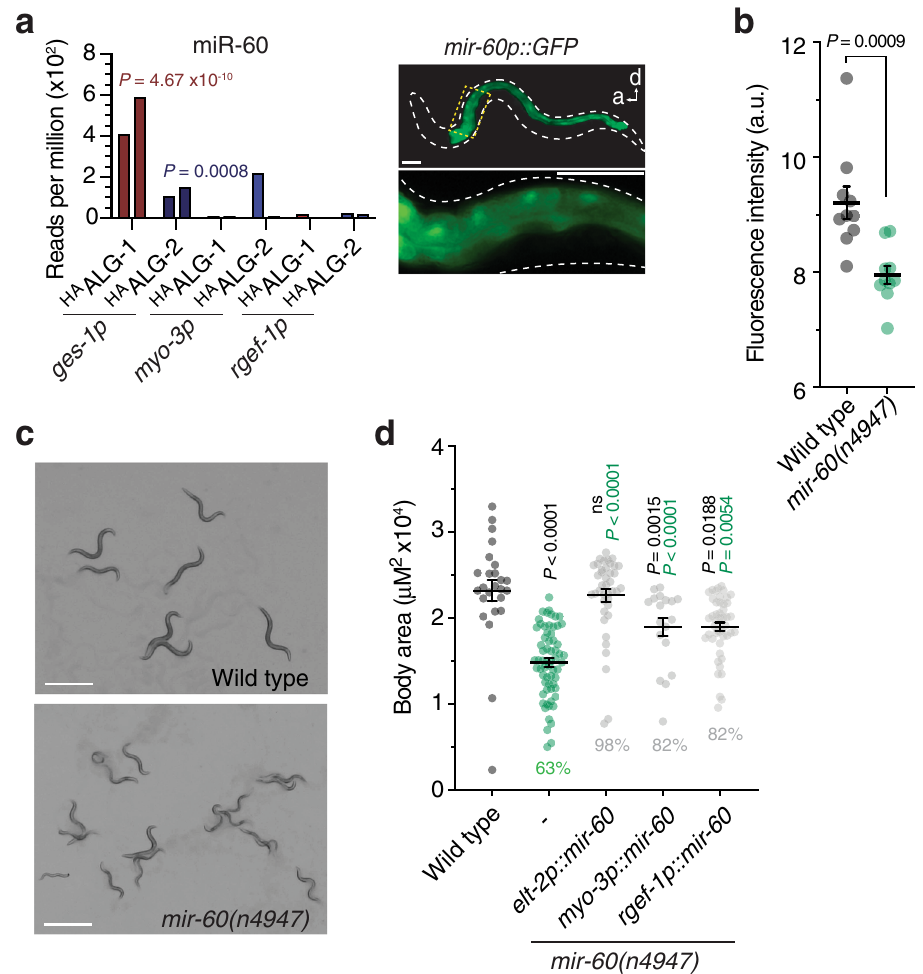
Fig. 6 Functionality of intestine-speci fi c miRNA. a Read counts showing intestine-speci fi c loading of miR-60 and promoter GFP fusion showing intestine-speci fi c expression. Graph shows reads per million in indicated cell types of two biological replicate experiments, two bars. Scale bars, 50 µ m. b Quanti fi cation ( fl uorescence intensity) of fat content using Oil Red O staining on wild-type and mir-60(n4947) starvation-recovered worms. Error bars represent + / − s.e.m of ten independent animals. P value represents a two-way unpaired Students t -test. a.u., arbitrary units. c Wild type or mir-60(n4947) animals after recovery from starvation. Scale bars, 1 mm. d Quanti fi cation of body area of cell-type-speci fi c complemented mir-60(n4947) . Percentages shown are the relative average body areas of animals compared to wild type. Error bars represent + / − s.e.m. P values represent one-way ANOVA with Tukey ’ s multiple comparisons test compared to wild type (black values) or mir-60(n4947) animals (green values). n ≥ 18 biologically independent animals for each strain